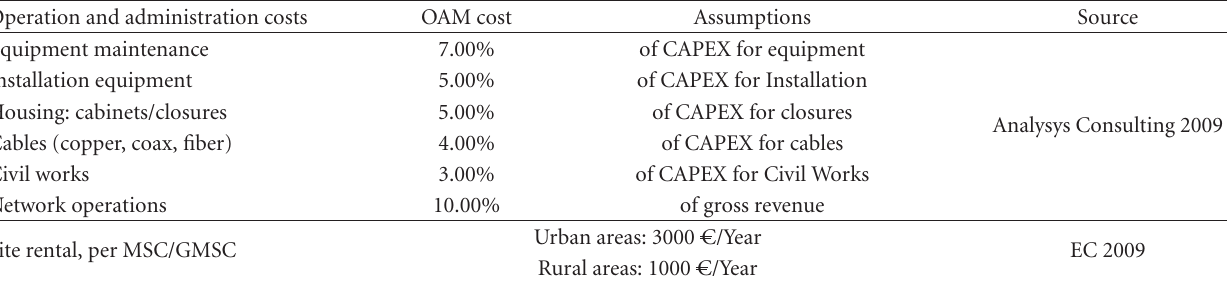
Table 9: Operation and administration costs (OPEX).